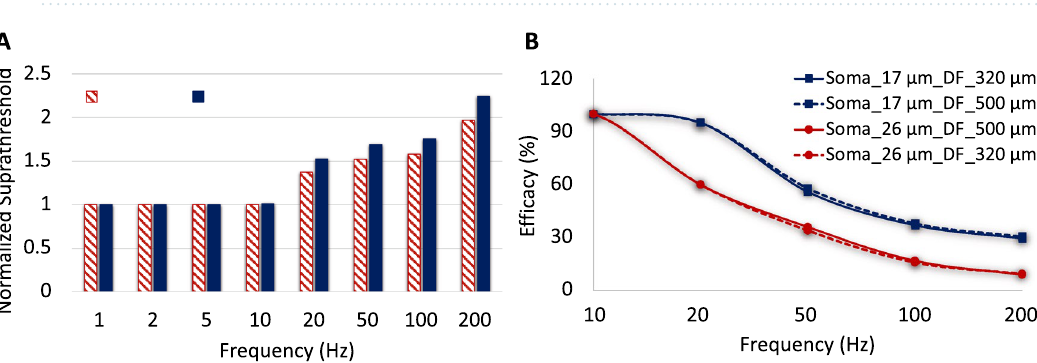
Figure 1. A2 and D1 realistic morphologies as implemented and coded in our multiscale Admittance Method/ NEURON computational platform 61–73 . Left: A2-monostratified RGC ramified in the inner part of inner plexiform layer and has a larger soma and dendritic field diameters. Right: D1-bistratified, their dendrites are placed in both inner and outer part of the inner plexiform layer and this cell has relatively smaller soma and dendritic field diameters. GCL: ganglion cell layer; IPL: inner plexiform layer; AH: axon hillock; SOCB: sodium channel band; NS: narrow segment; DA: distal axon; L: length of each band; D: diameter. The morphology of RGCs was extracted from the NeuroMorpho dataset 75–77 .